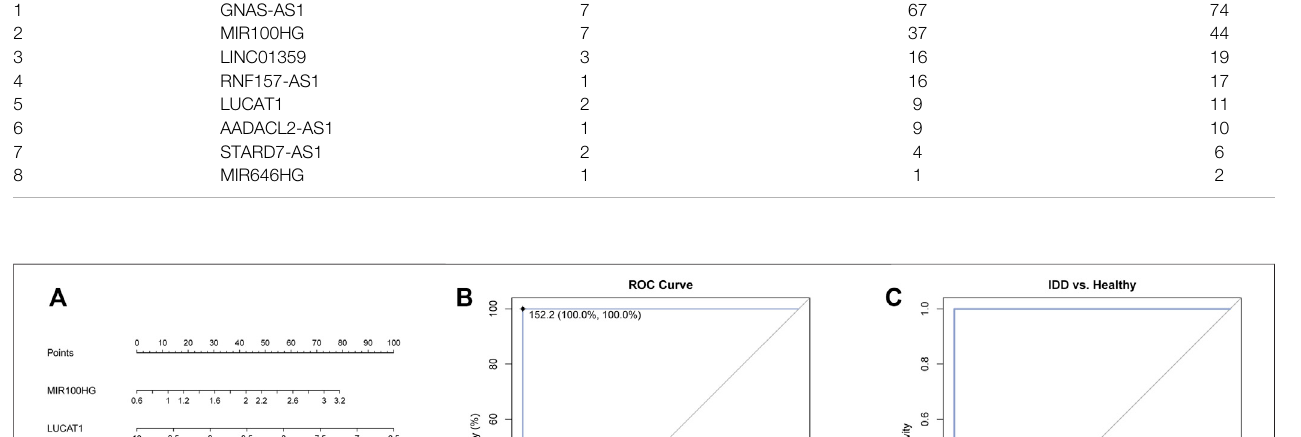
TABLE 5 | The number of fi rst-relationship lncRNA-miRNA pairs and second-relationship miRNA-mRNA pairs.